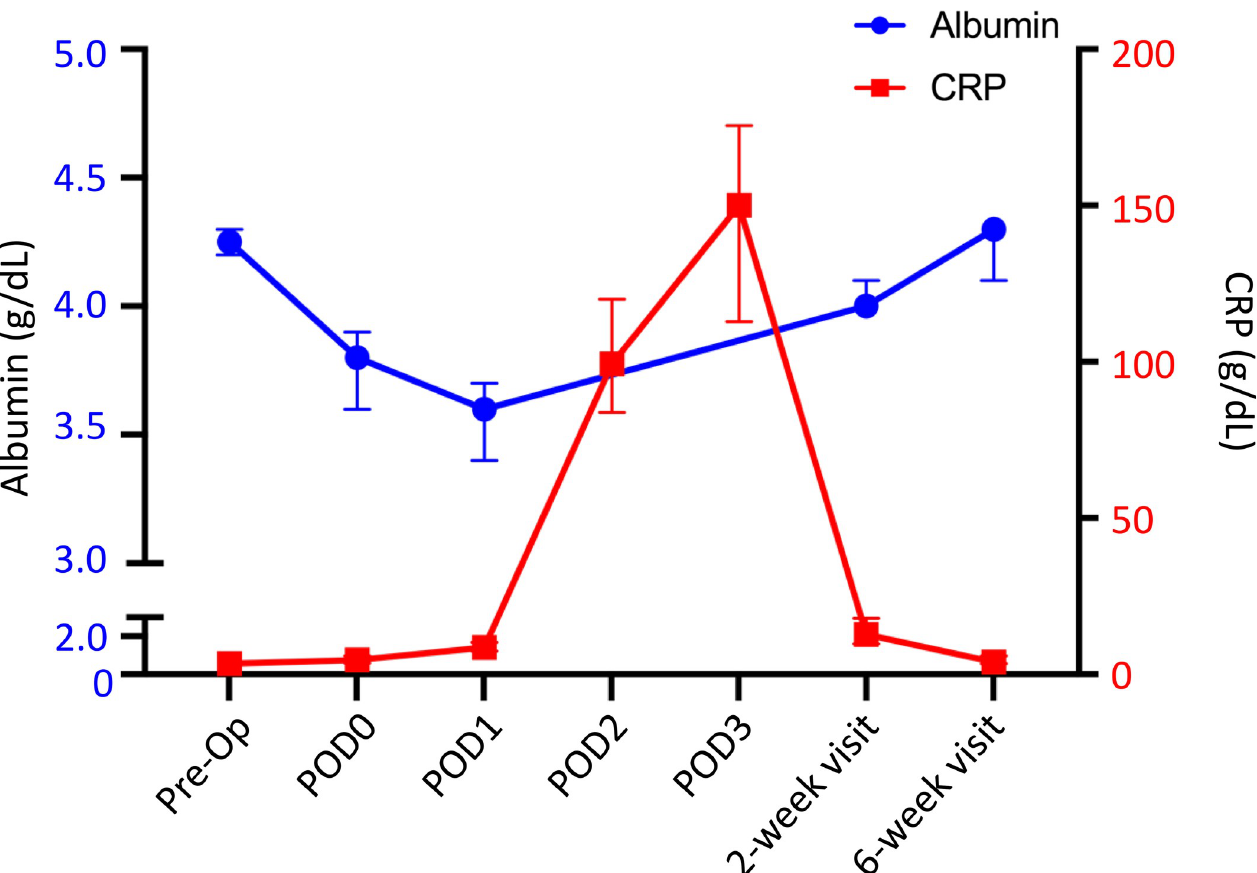
Fig 1. Median circulating albumin (blue circle) and CRP (red square) following TKA. Y-error bars depict a CI of 95%. r = -0.41.